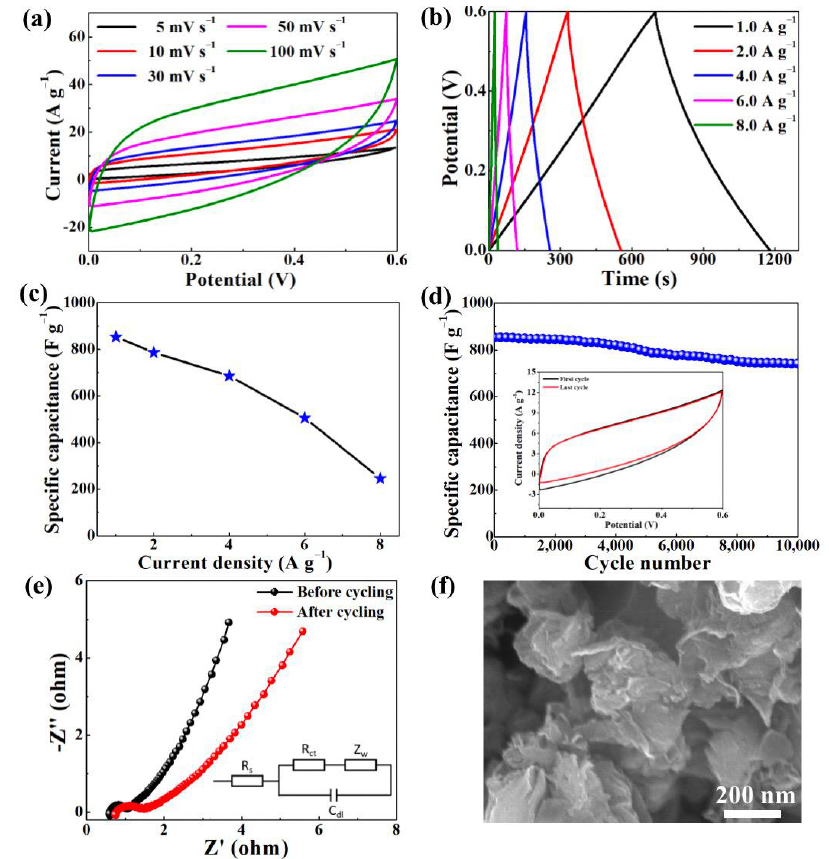
Figure 3. ( a ) CV curves of the MoS 2 /Gr electrode, recorded at different scan rates. ( b ) GCD curves of the MoS 2 /Gr electrode at different current densities. ( c ) Specific capacitance of the MoS 2 /Gr electrode at different current densities. ( d ) Cycling performance of the MoS 2 /Gr electrode at a scan rate of 30 mV s − 1 (inset, the CV curves before and after cycling test). ( e ) EIS data of the MoS 2 /Gr electrode before and after 10,000 cycles (inset, the equivalent circuit of the MoS 2 /Gr electrode). ( f ) SEM image of the MoS 2 /Gr electrode after 10,000 cycles. Table 1. Comparison of the specific capacitance of the electrode in this work compared with those based on MoS 2 /Gr hybrids reported in the literature.